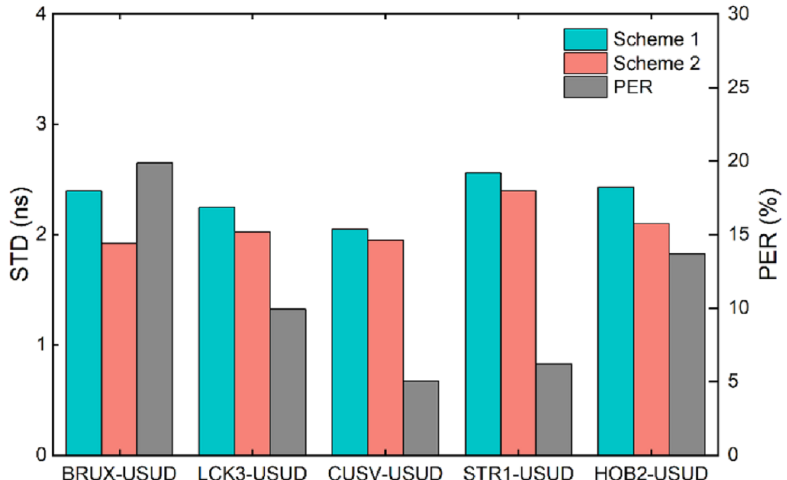
Figure 12. The clock difference between the SF SPP time transfer solutions and GBM PPP time transfer solutions for five time links with the two schemes.